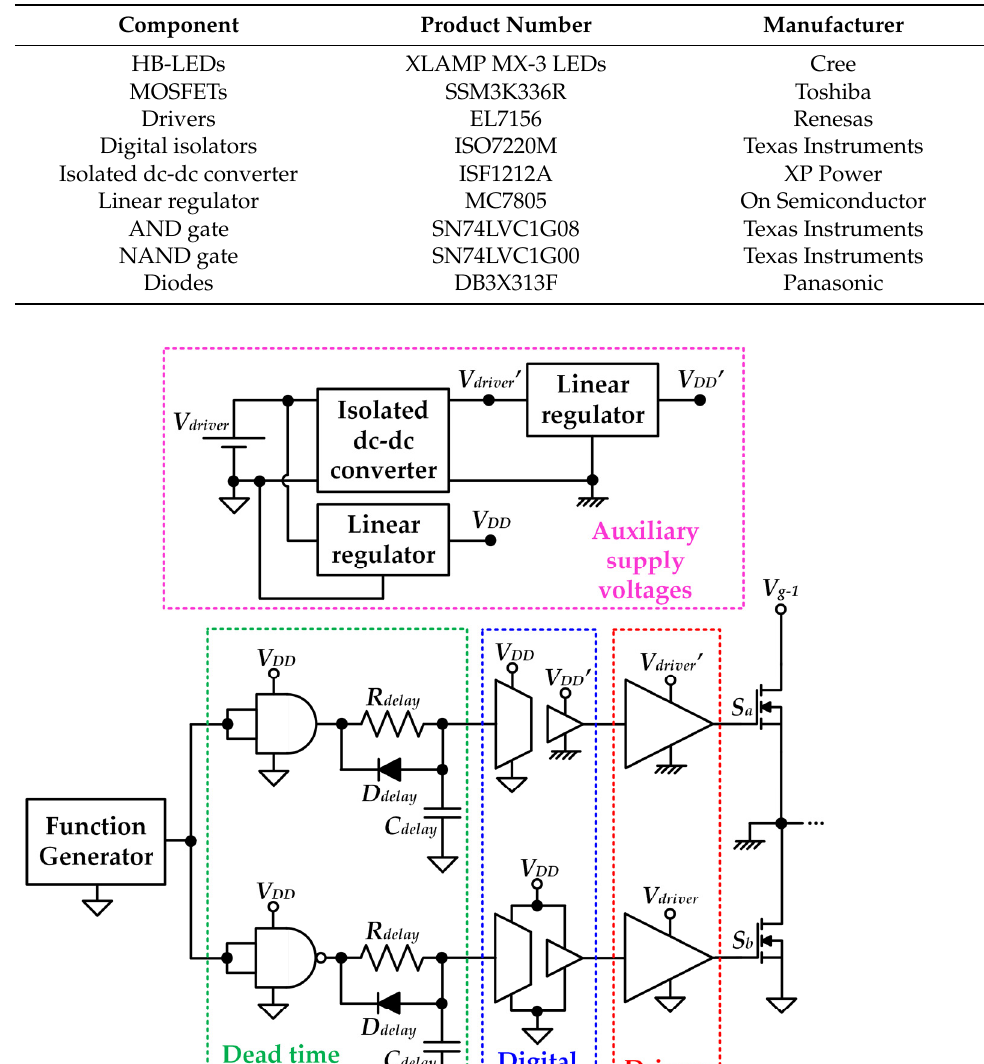
Table 1. Main components of the RF-PWM Class D SMPA prototype.